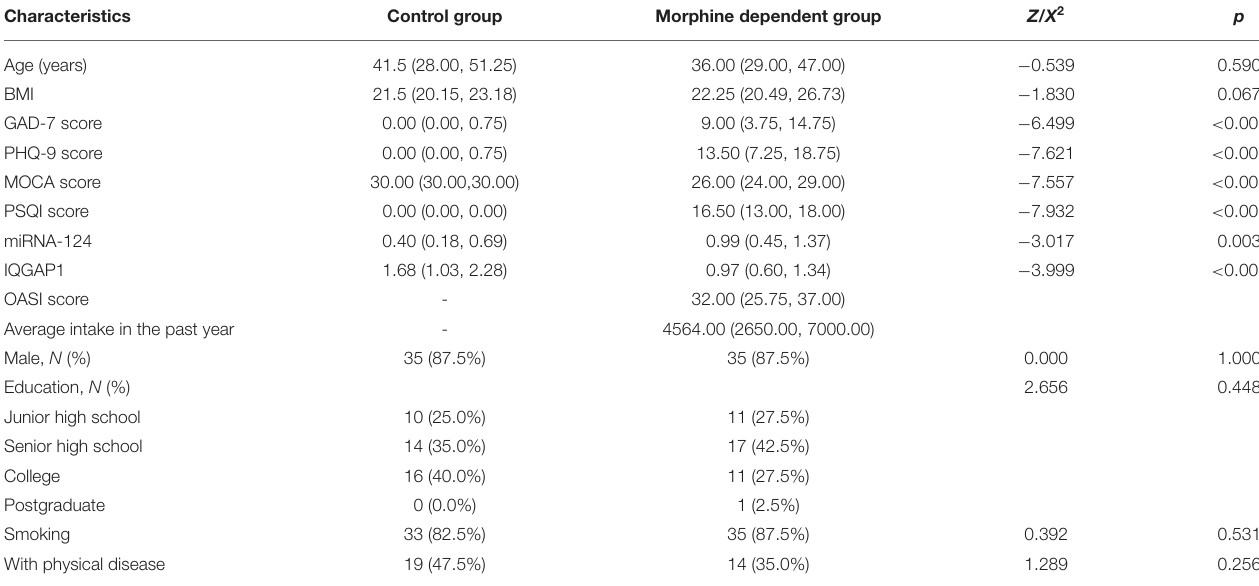
TABLE 1 | Comparison of demographic and clinical variables between morphine-dependent and control groups. Characteristics